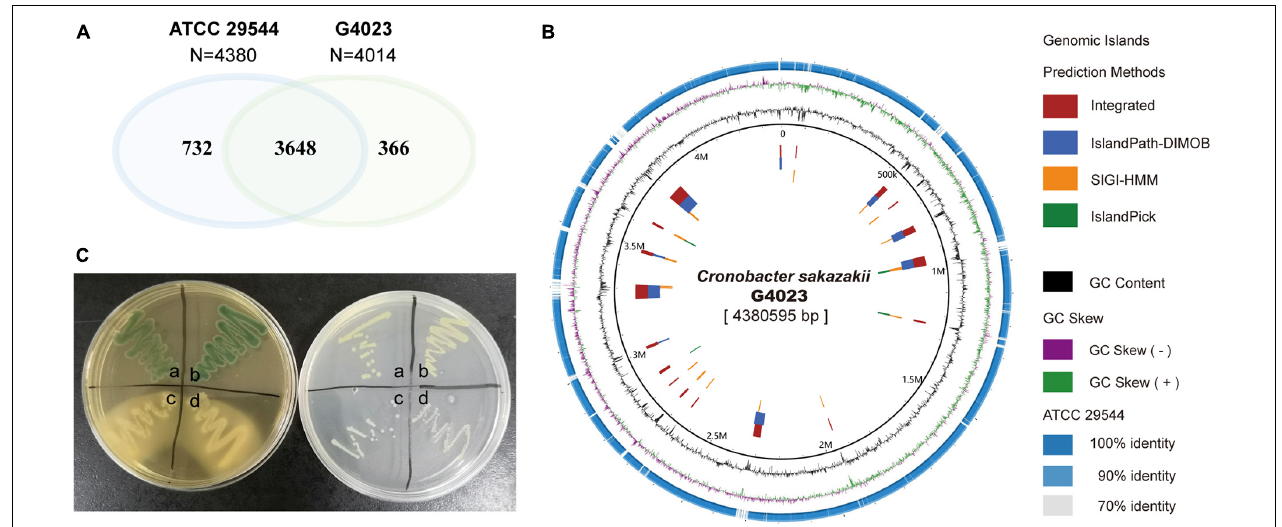
FIGURE 1 | Genomic and biochemical comparisons between C . sakazakii G4023 and ATCC 29544. (A) Venn diagram shows the numbers of homologous and specific gene in genomes of C . sakazakii G4023 and ATCC 29544. (B) Genomic comparison of C . sakazakii G4023 and ATCC 29544 suggests the specific genes in G4023 mainly localized in genomic islands. (C) Bacteria colonies on DFI agar (left) and LB agar (right). ATCC 29544 forms green/blue colonies on DFI agar and produces yellow pigment on LB agar (a), which are identical to that of G4023 (b); Salmonella Typhimurium ATCC 14028 (c) and EHEC O157: H7 EDL933 (d) present white colonies on both agar mediums.